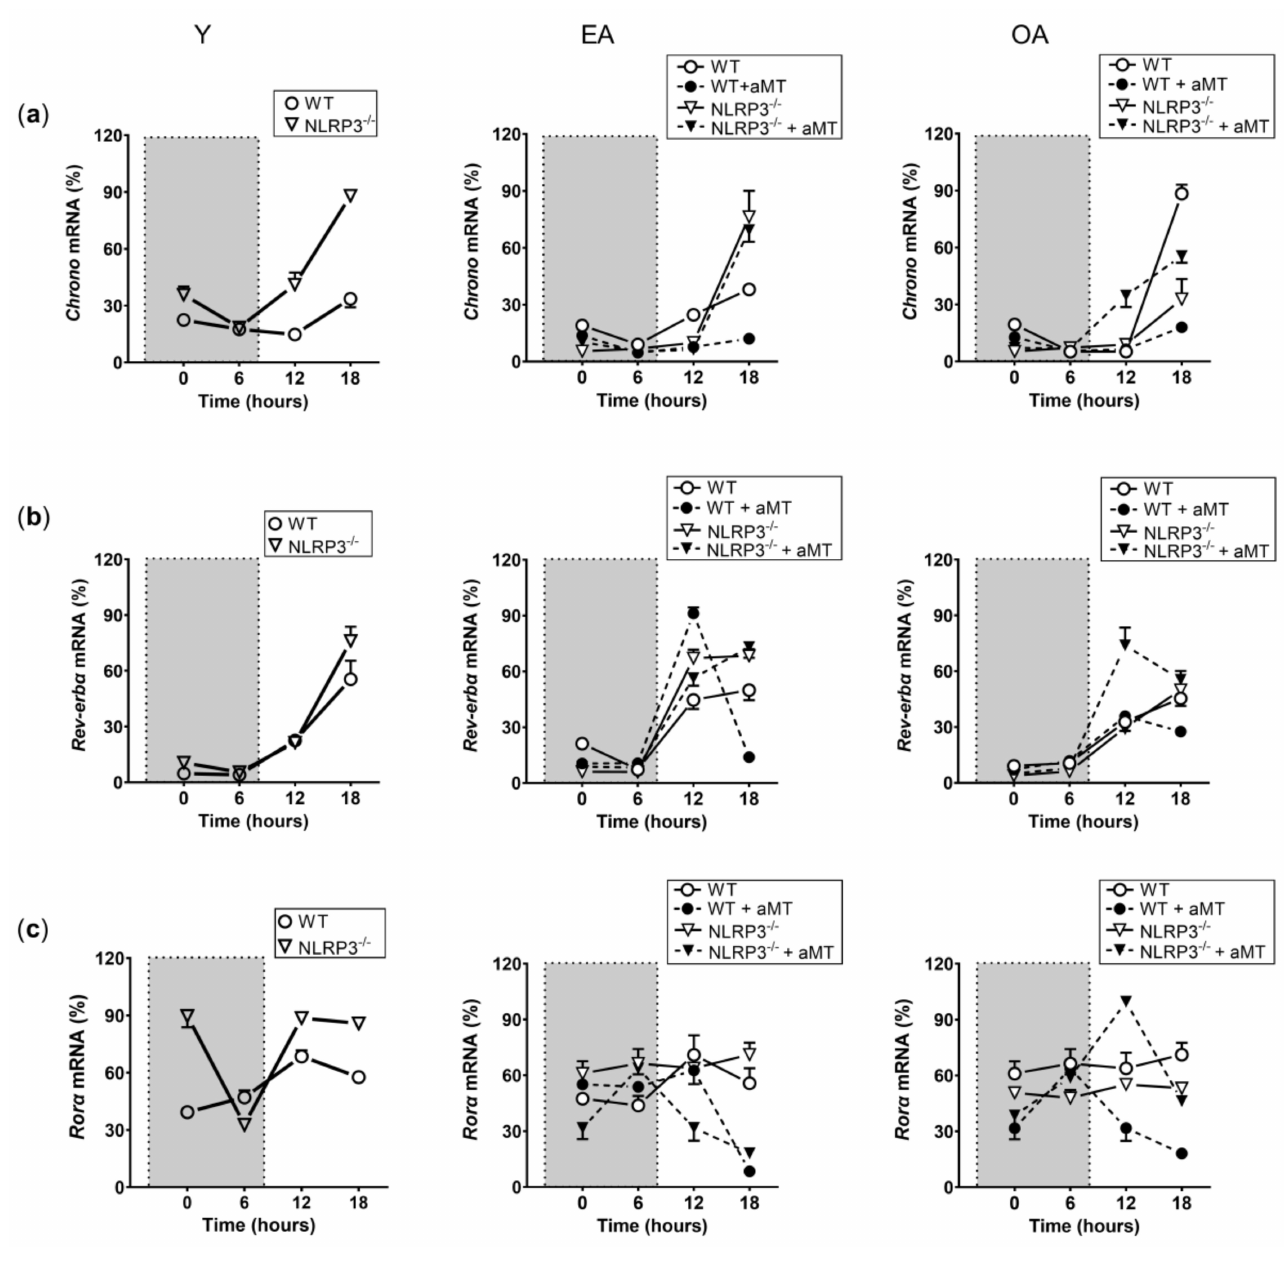
Figure 2. Changes in the relative expression of the Chrono , Rev-erb α , and Ror α transcripts in WT and NLRP3 − / − mice during aging and melatonin treatment. Relative expression of the Chrono ( a ), Rev-erb α ( b ), and Ror α ( c ) transcripts in hearts of young (Y), early-aged (EA), early-aged with melatonin (EA + aMT), old-aged (OA), and old-aged with melatonin (OA + aMT) wild type and NLRP3 − / − mice and their daily patterns at 4 time points (00:00, 06:00, 12:00, and 18:00 h) under a 12 h/12 h light/dark cycle. The shaded region on each graph represents constant darkness. Data are expressed as means ± SEM (n = 6 animals/group). Data of significant differences among the experimental groups were evaluated by Tukey multiple comparison of mean post hoc test following ANOVA and are detailed in Supplementary Table S1: Table S1.4 ( Chrono ), S1.5 ( Rev-erb α ), S1.6 ( Ror α